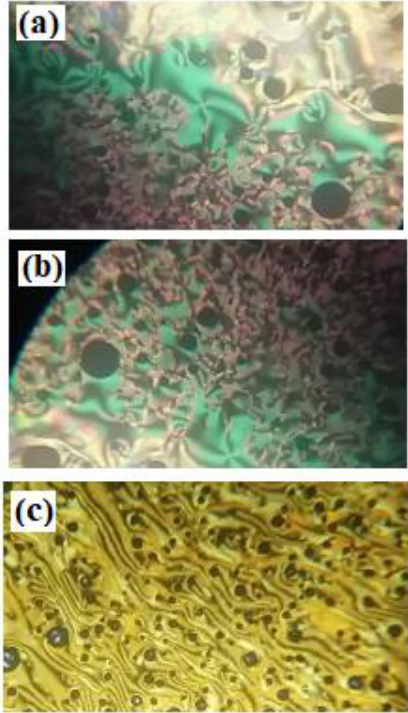
Figure 4. Nematic polarizing optical microscopy (POM) textures on heating for 2:1 supramolecular complexes ( a ) I12/B at 218.0 °C, ( b ) I12/B at 225.0 °C ( c ) and I8/B at 180.0 °C phases. complexes ( a ) I12 / B at 218.0 ◦ C, ( b ) I12 / B at 225.0 ◦ C ( c ) and I8 / B at 180.0 ◦ C